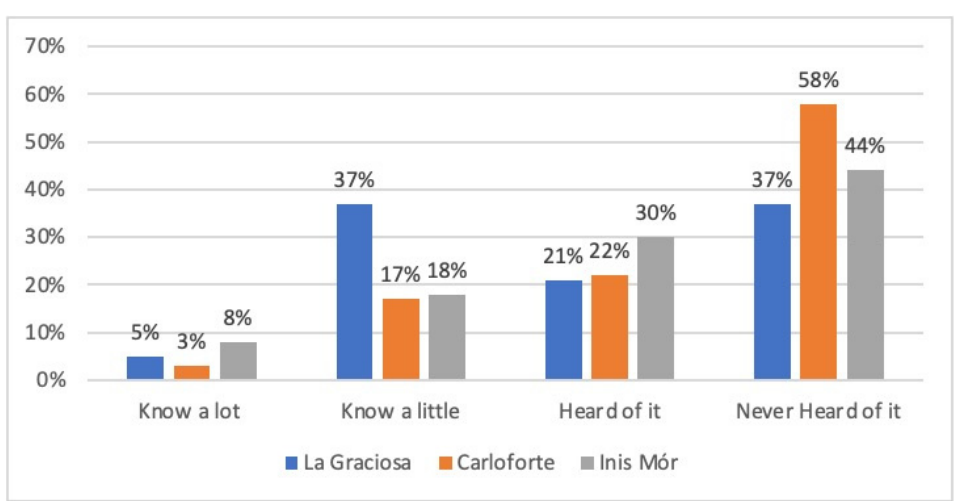
Figure 5. Familiarity of the three island residents with the Smart Grid concept.